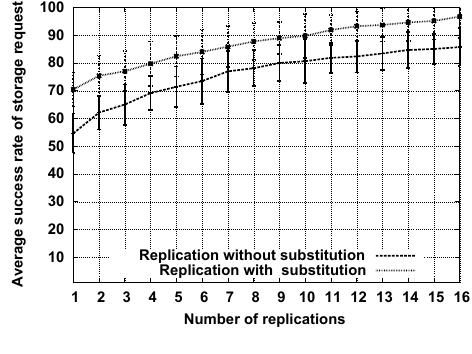
Figure 13. Success rate evaluation in the